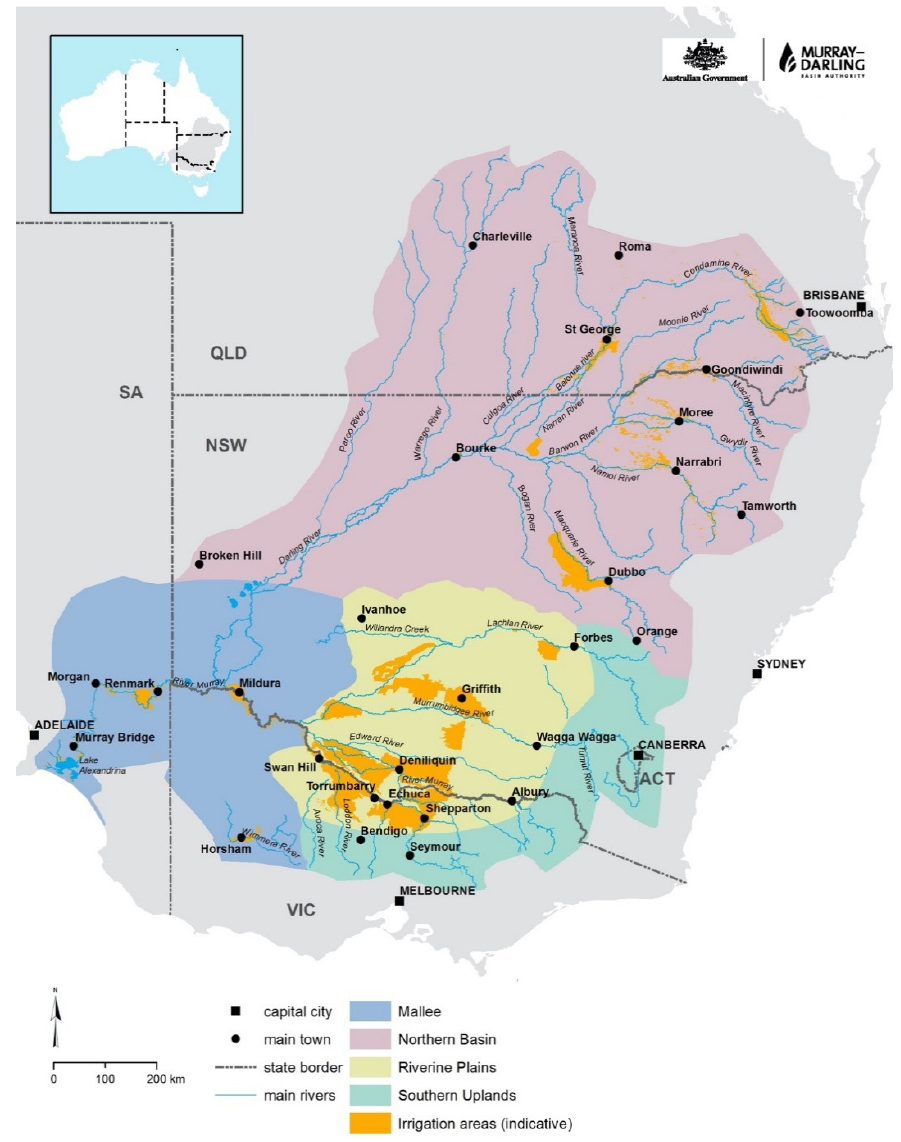
Figure 1. The Murray–Darling Basin showing the river systems, major irrigation regions, and the Basin states (New South Wales, Victoria and South Australia, Queensland, and the Australian Capital Territory) (Source: MDBA).